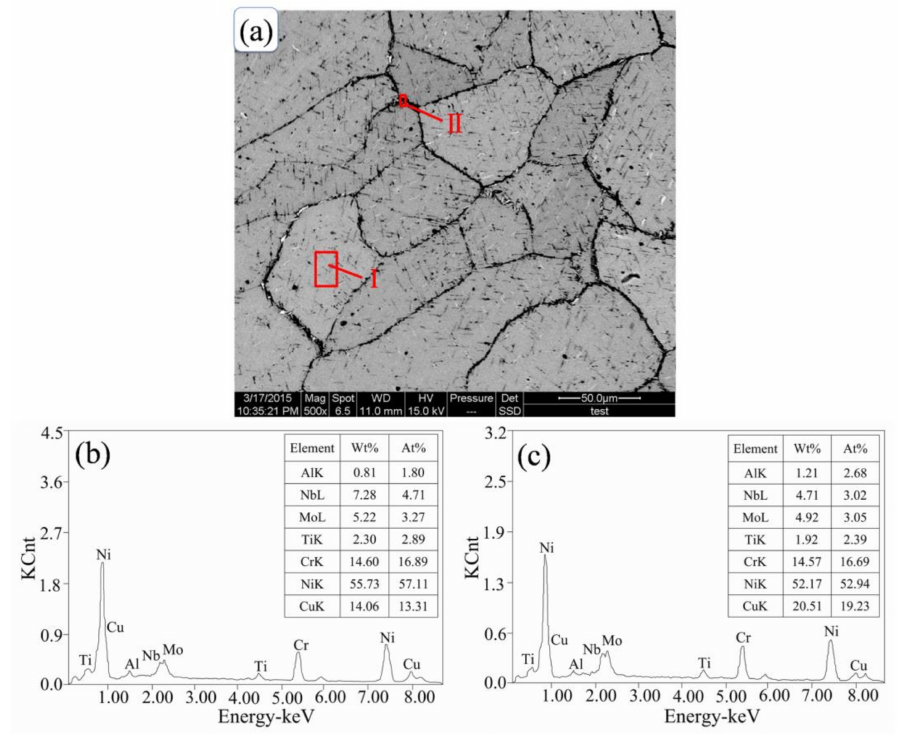
Figure 5. SEM micrographs of heat-treated Ni-Nb5 alloy along with EDS maps: ( a ) SEM micrograph; ( b ) EDS map of zone I in ( a ); ( c ) EDS map of zone II in ( a